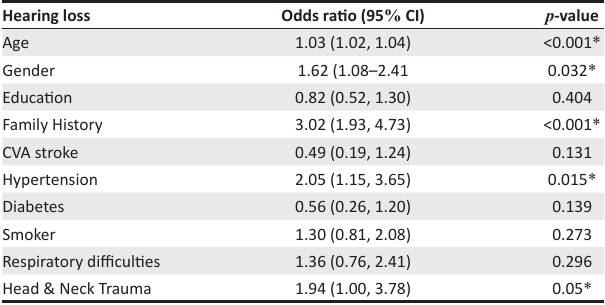
TABLE 4: Factors associated with hearing